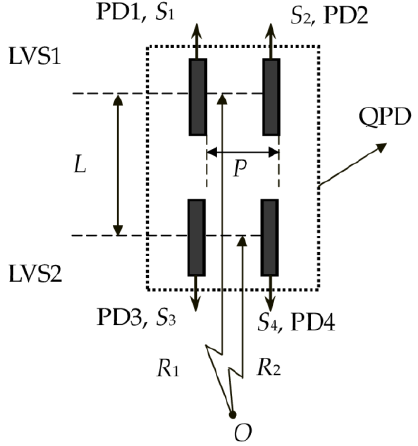
Figure 1. Structure of the QPD formed by four photovoltaic cells.